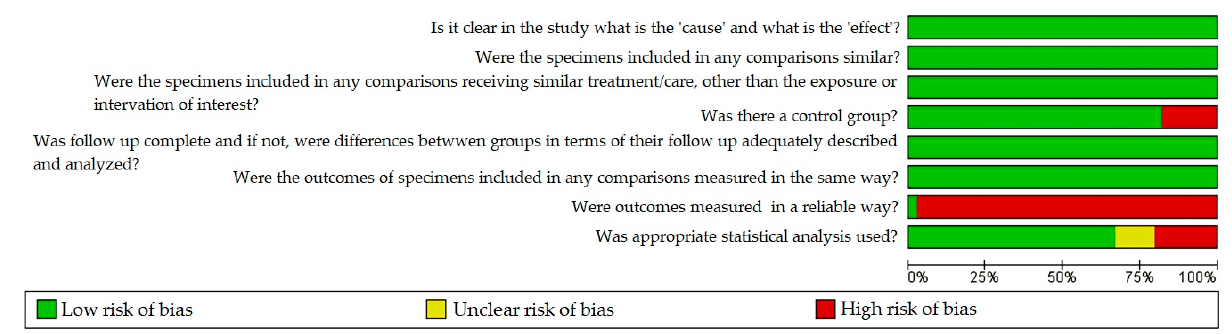
Figure 2. Risk-of-bias graph of included studies.